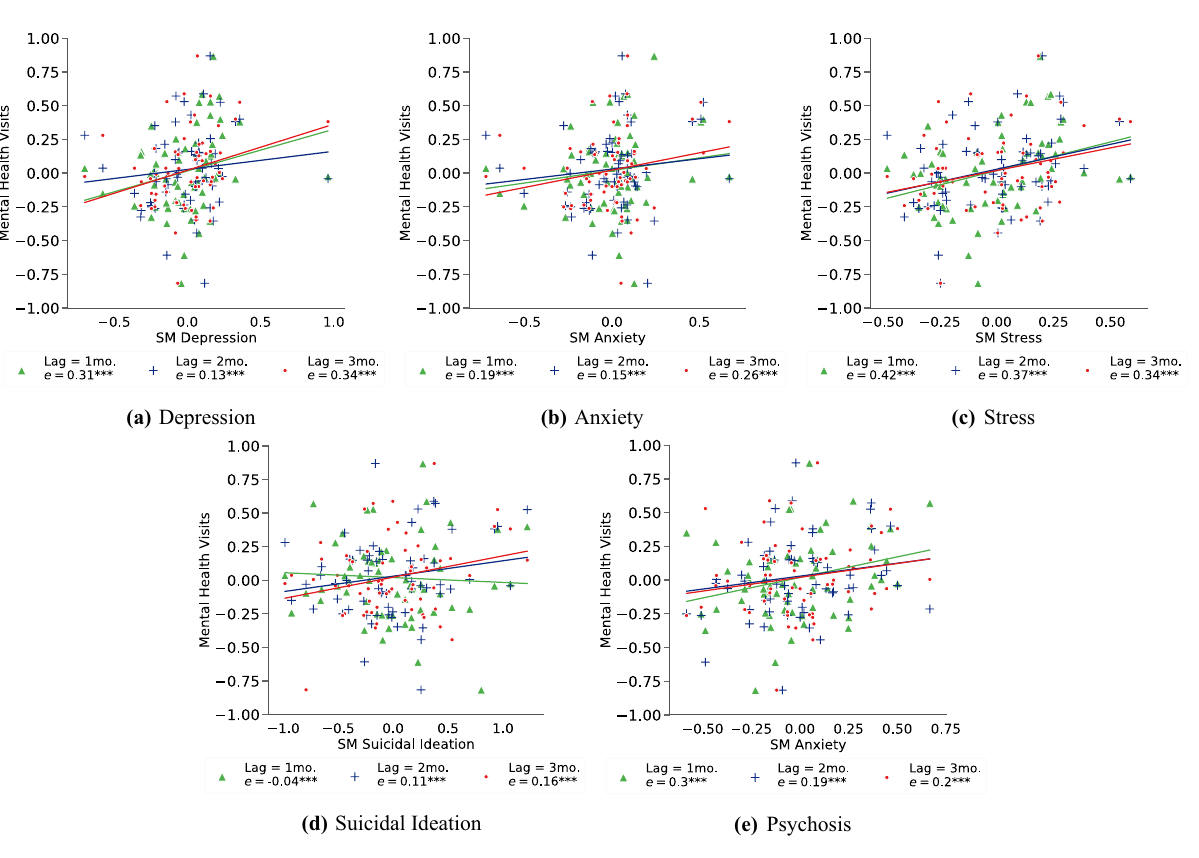
Figure 2. Lagged cross-correlation between the trend-seasonality removed residuals of on-campus mental health consultations (visits) and mental health symptomatic expressions on social media